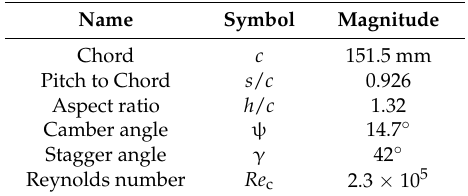
Table 1. Aerodynamic and geometric parameters of the cascade.